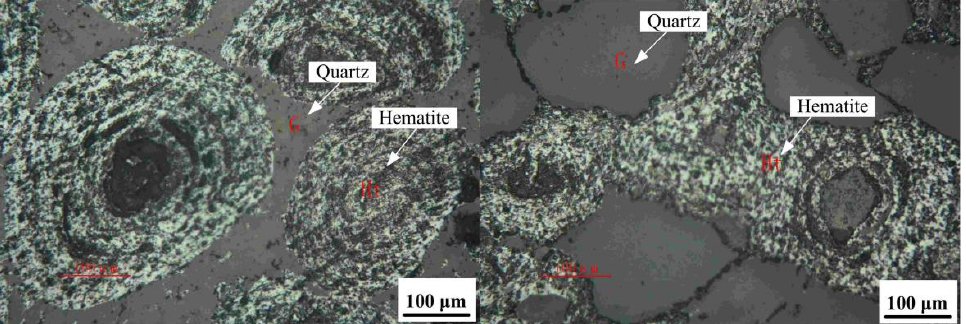
Figure 2. Optical microscope photos of the main minerals in the ore.